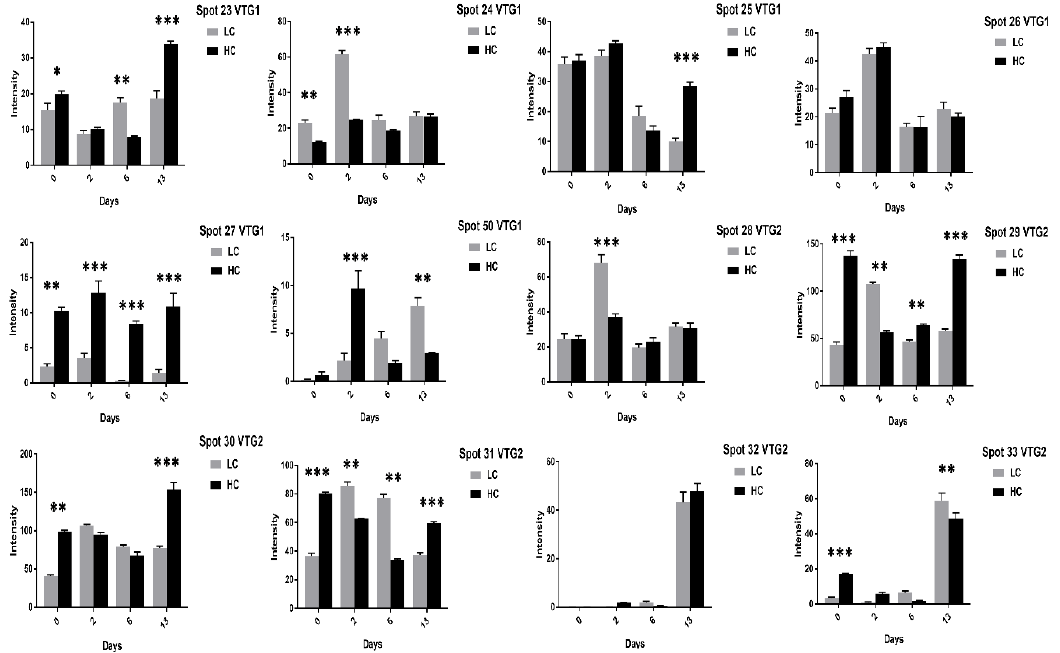
Figure 11. A comparison of low and high cholesterol egg yolk proteins (VTG-1 and VT-2) spots after 0, 2, 6, and 13 days of incubation was performed. The column profiles of VTG-1 and VTG-2 are shown as bar charts with significant differences. The data represent the mean values of three replicates and the error bars denote the standard deviation. * p < 0.05, ** p < 0.005, *** p < 0.0001.